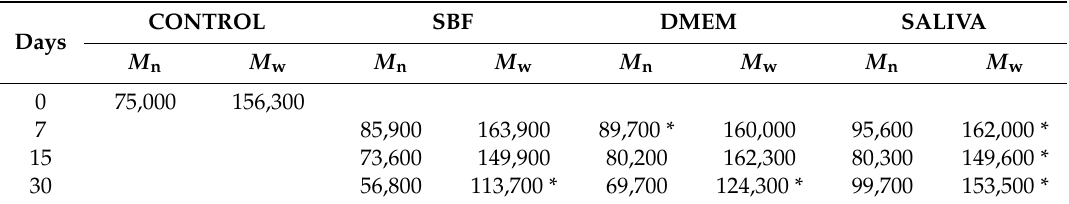
Table 2. Number ( M n ) and weight ( M w ) average molecular weights for irradiated PLGA nonwovens obtained in di ff erent in vitro degradation